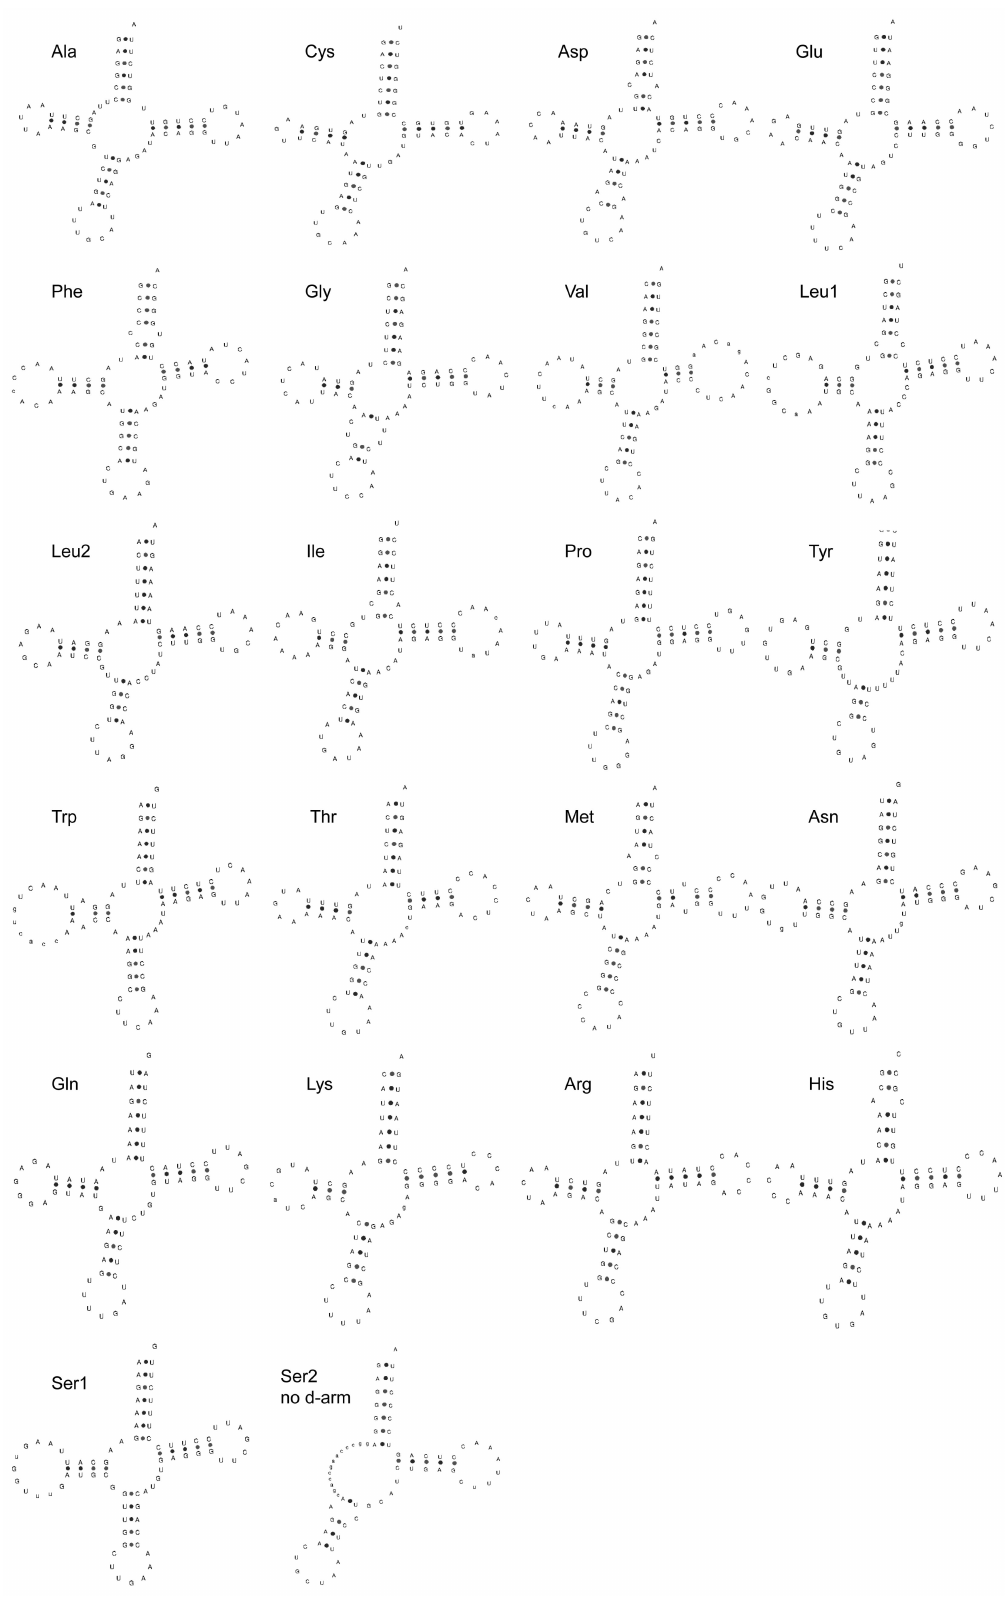
Figure 4. The inferred secondary structure of 22 tRNA genes from the Pingpu Yellow